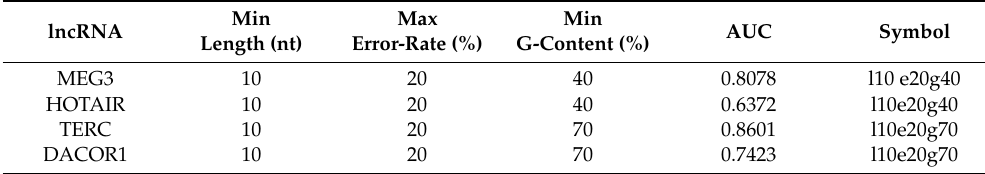
Figure 1. Triplexes predictions for four lncRNAs (TERC, MEG3, DACOR1, HOTAIR) and their experimentally validated target regions with di ff erent Triplexator parameters: minimum triplex length, maximum error rate, and minimum G-content. Prediction quality is measured using the AUC (color scheme). Gray color represents the absence of predicted triplexes. Table 1. Triplexator parameters that generated the best results for each of the four analyzed lncRNAs. Overall, we recommend using a minimum length of 10 bp, a maximum error-rate of 20%, and test a minimum G-content of 40% and